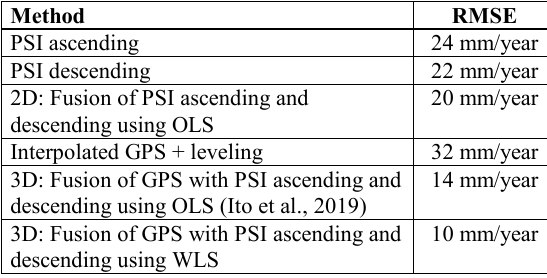
Table 2. Comparison between estimated vertical results and validation data